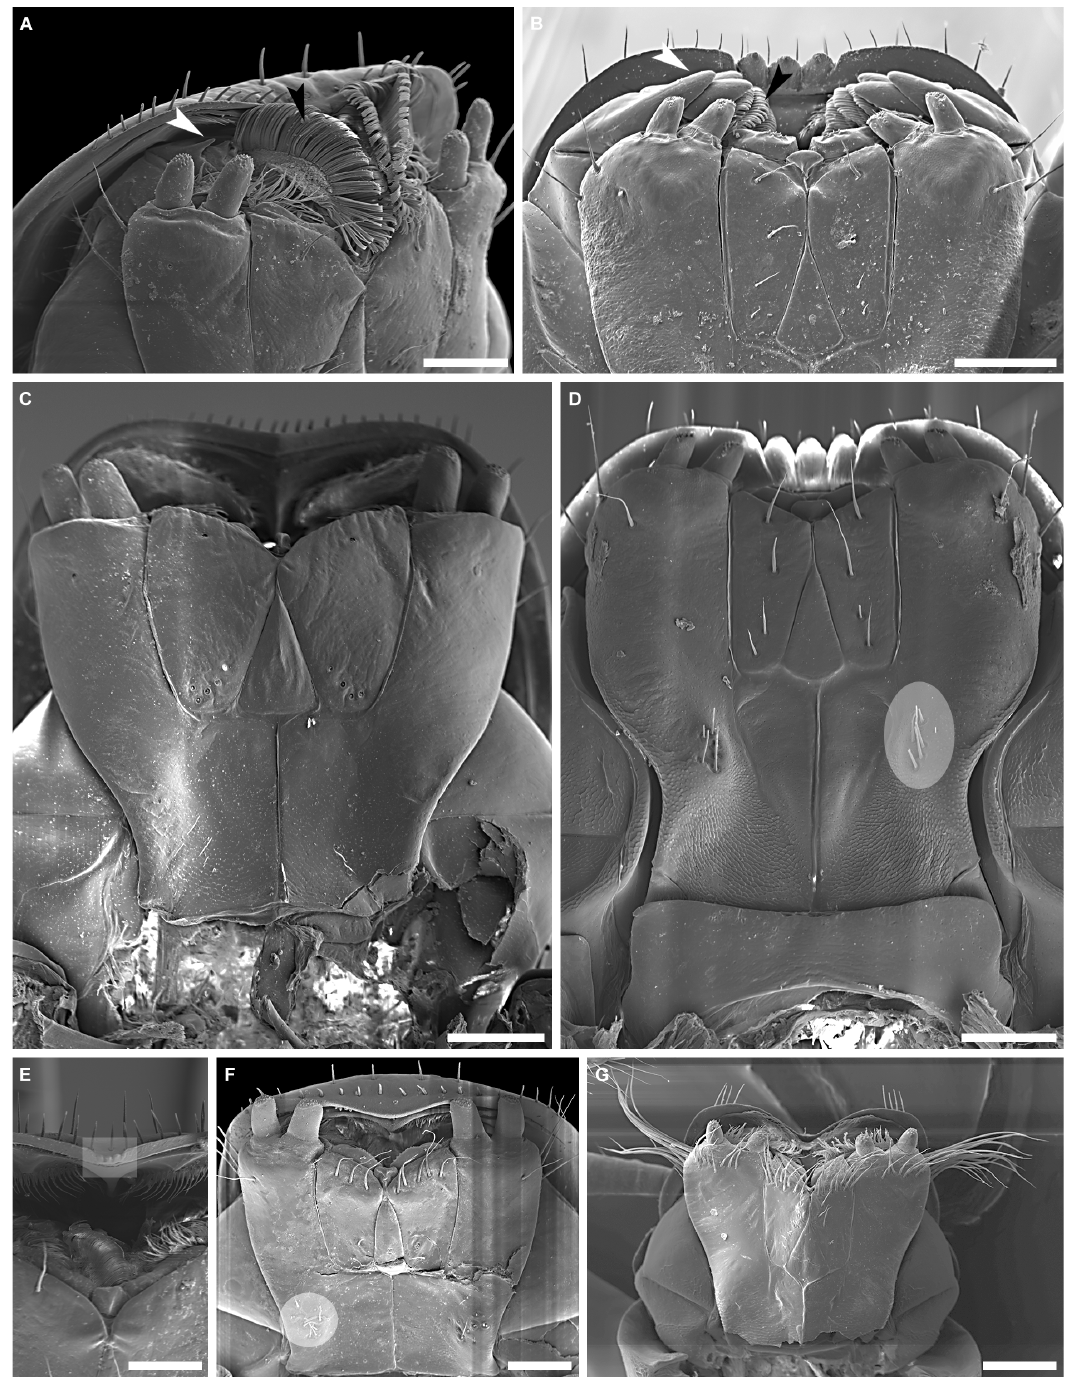
Fig. 55. Head of species in the genus Leucogeorgia Verhoeff, 1930. A . L. caudata sp. nov., ♂ from Adzaba Cave, ventrolateral view (ZMUM). B . L. prometheus sp. nov., ♂ from Sataplia II Cave, ventral view (ZMUM). C . L. turbanovi sp. nov., paratype ♂, ventral view (SMNG). D . L. prometheus sp. nov., ♂ from Sataplia I Cave, ventral view (SMNG). E . L. rediviva Golovatch, 1983, ♂ from Khabyu Cave, ventral view (SMNG). F . L. longipes Verhoeff, 1930, ♂ from Dolabistavi Cave, ventral view (SMNG). G . L. mystax sp. nov., holotype ♂, ventral view (ZMUM). White arrows indicate mandibular teeth, black arrows indicate pectinate teeth, transparent oval and circle show medial group of shorter setae on stipites, transparent rectangle shows three reduced labral teeth. Scale bars: 0.2